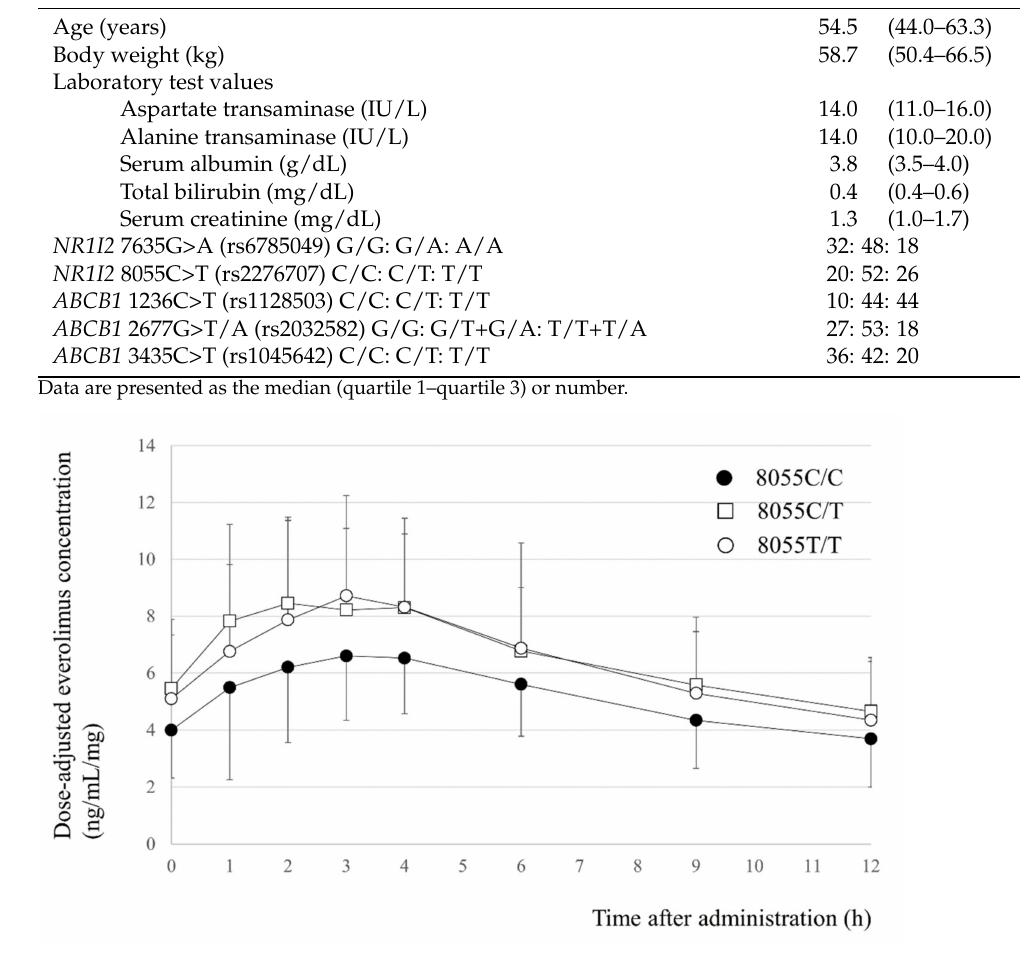
Figure 1. Mean ( ± standard deviation) plasma concentration–time profiles of everolimus in renal transplant recipients with the NR1I2 8055C/C (closed circles, n = 20), 8055C/T (open squares, n = 52), or 8055T/T genotype (open circles, n = 26) on day 15 after initiation of everolimus treatment at a dose of 0.75 mg twice daily (1.5 mg daily dose) in combination with tacrolimus. The dose-adjusted C 0 and AUC 0-12 values of everolimus in male patients were sig- nificantly higher than those in female patients ( p = 0.004 and 0.045, respectively; Table 3). Significant correlations were observed between the dose-adjusted C 0 of everolimus on day 15 after beginning therapy and age ( p < 0.001), body weight ( p = 0.028), aspartate transaminase ( p < 0.001), alanine transaminase ( p < 0.001), and total bilirubin ( p = 0.039; Table 3). Furthermore, significant correlations were found between the dose-adjusted AUC 0-12 of everolimus and age ( p = 0.001), aspartate transaminase ( p = 0.001), and alanine transaminase ( p = 0.005; Table